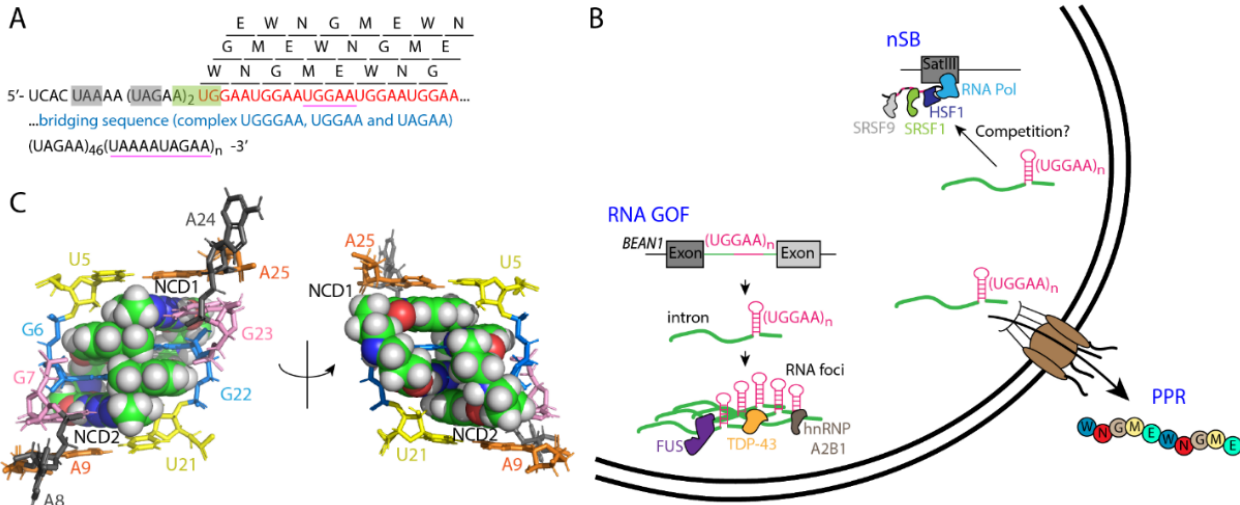
Figure 3. SCA31 RNA-mediated toxicity and PPR protein synthesis. ( A ) The insertion sequence with UGGAA repeat expansion (red) in SCA31 patients. The bridging sequence is highlighted in blue. Translation of UGGAA repeats in all 3 reading frames gives rise to a single PPR protein, poly-WNGME (single letters for amino acids). Stop (UAA and UAG) and start (AUG) codons are highlighted by grey and green boxes, respectively. The FISH probe target sites for RNA foci detection are underlined in purple. ( B ) RNA-mediated pathology in SCA31. The expanded UGGAA RNA could (1) form RNA foci that sequester TDP-43, FUS, and hnRNP A2B1; (2) compete with UGGAA-rich SatIII RNA that is induced by thermal stress to form nSB with SRSF1, SRSF9, and HSF1; and (3) be exported into the cytoplasm to initiate PPR protein synthesis. ( C ) High-resolution NMR structure (PDB entry 6IZP) of a 5 UGGAA 9 / 21 UGGAA 25 pentad (sticks) complexed with two NCD molecules (spheres).